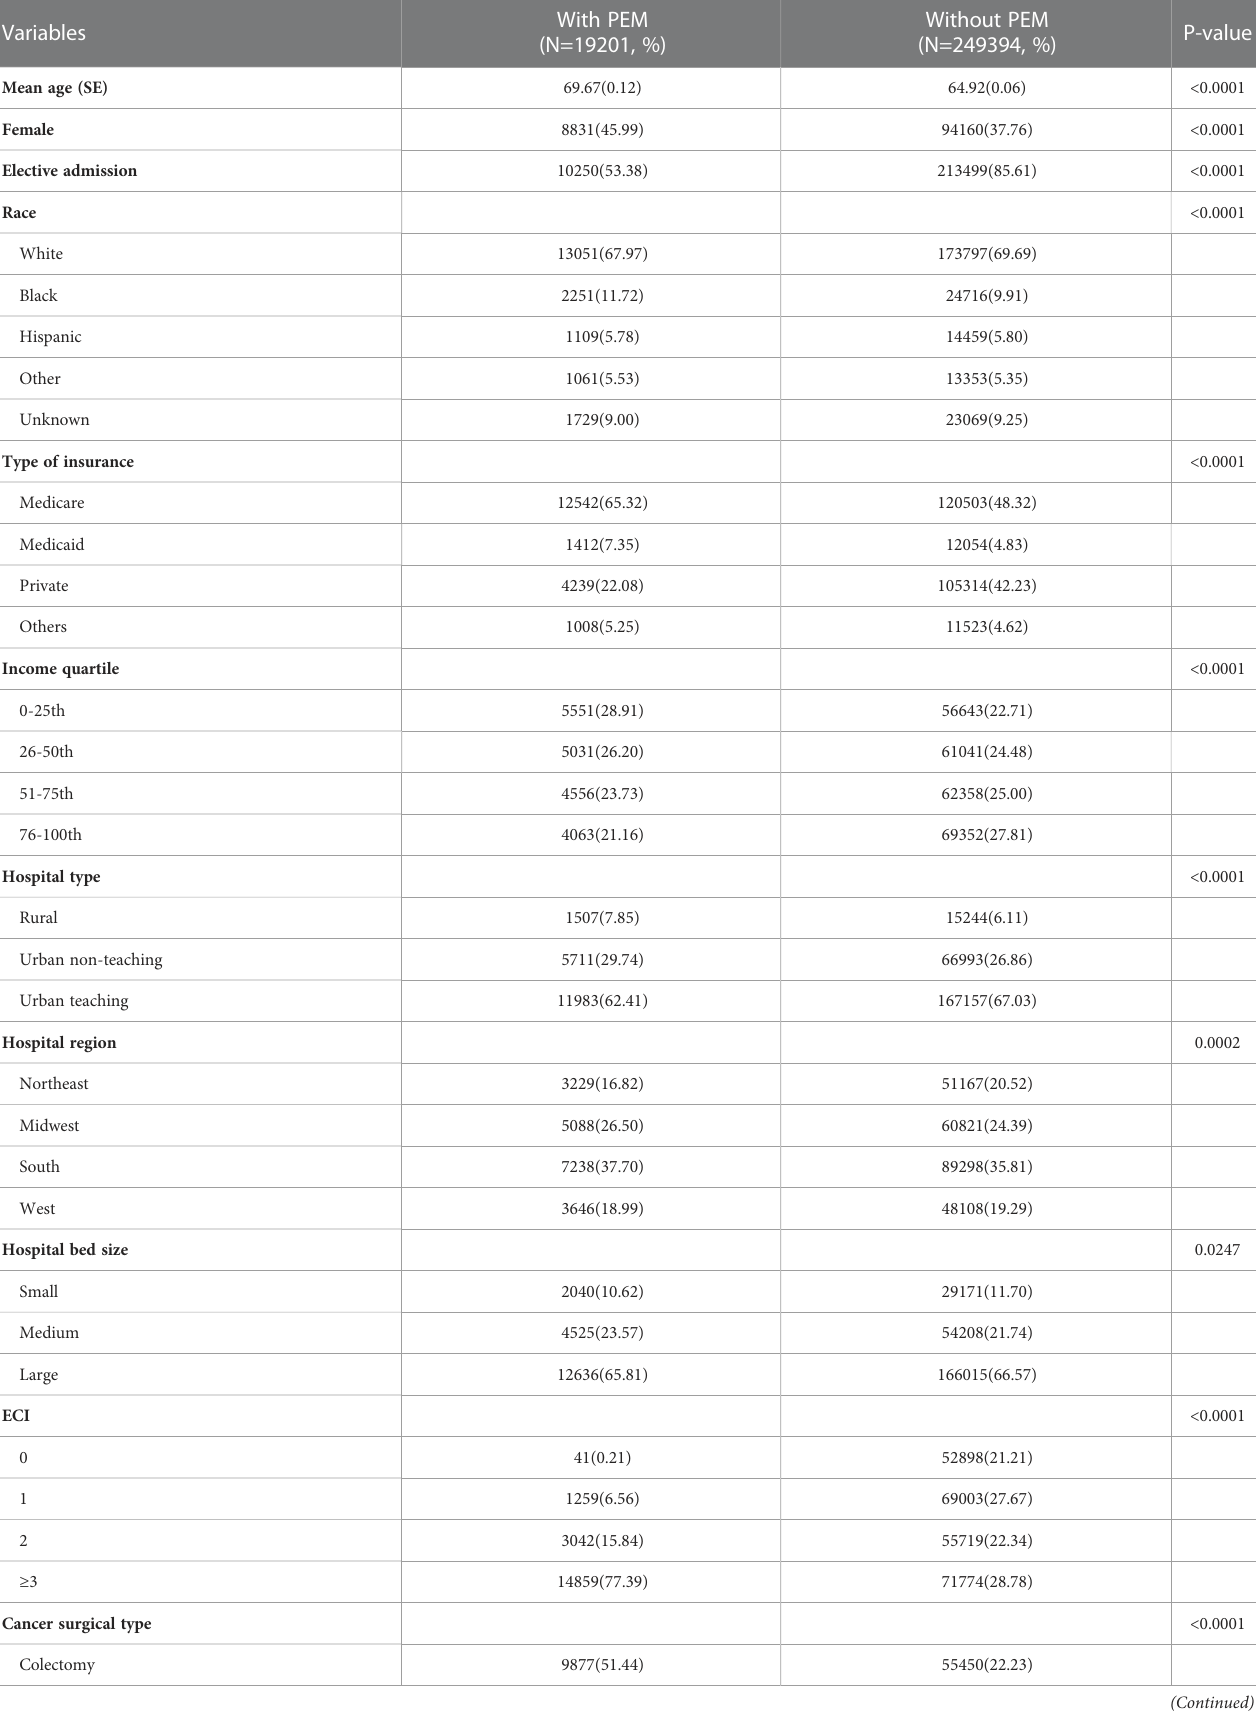
TABLE 1 Baseline characteristics in patients undergoing major cancer surgery with and without